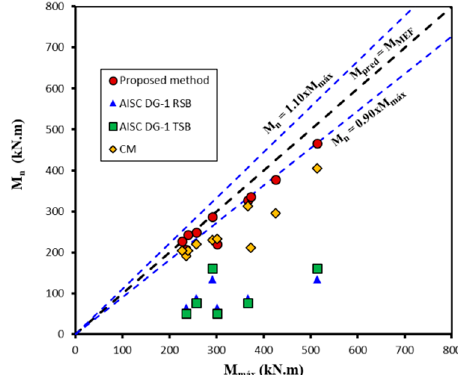
Figure 11. Comparison of flexural strength estimations of the different methods with FEM results for non-stiffened base plates.